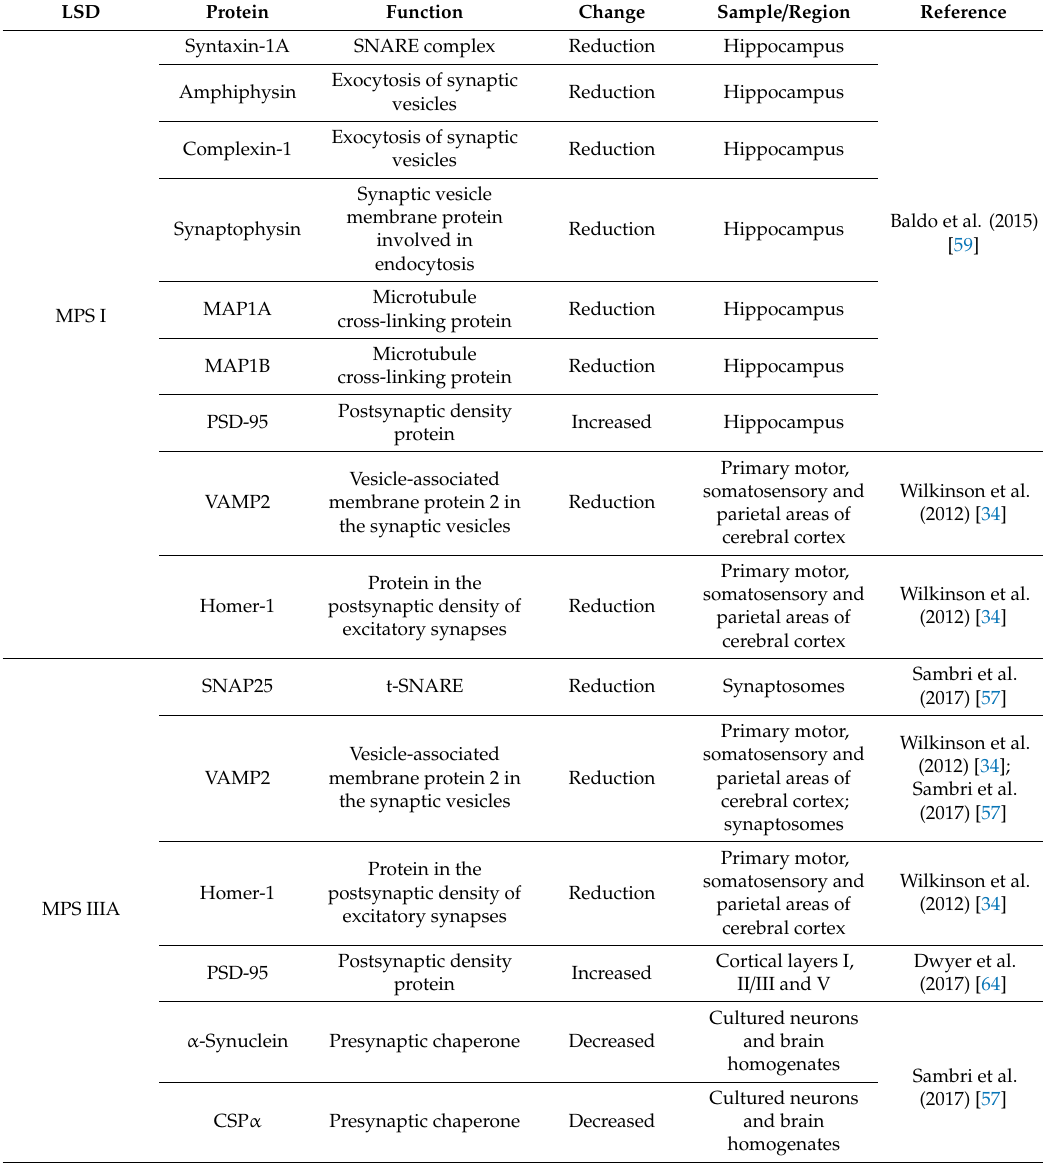
Table 1. Synaptic proteins altered in neurological lysosomal storage